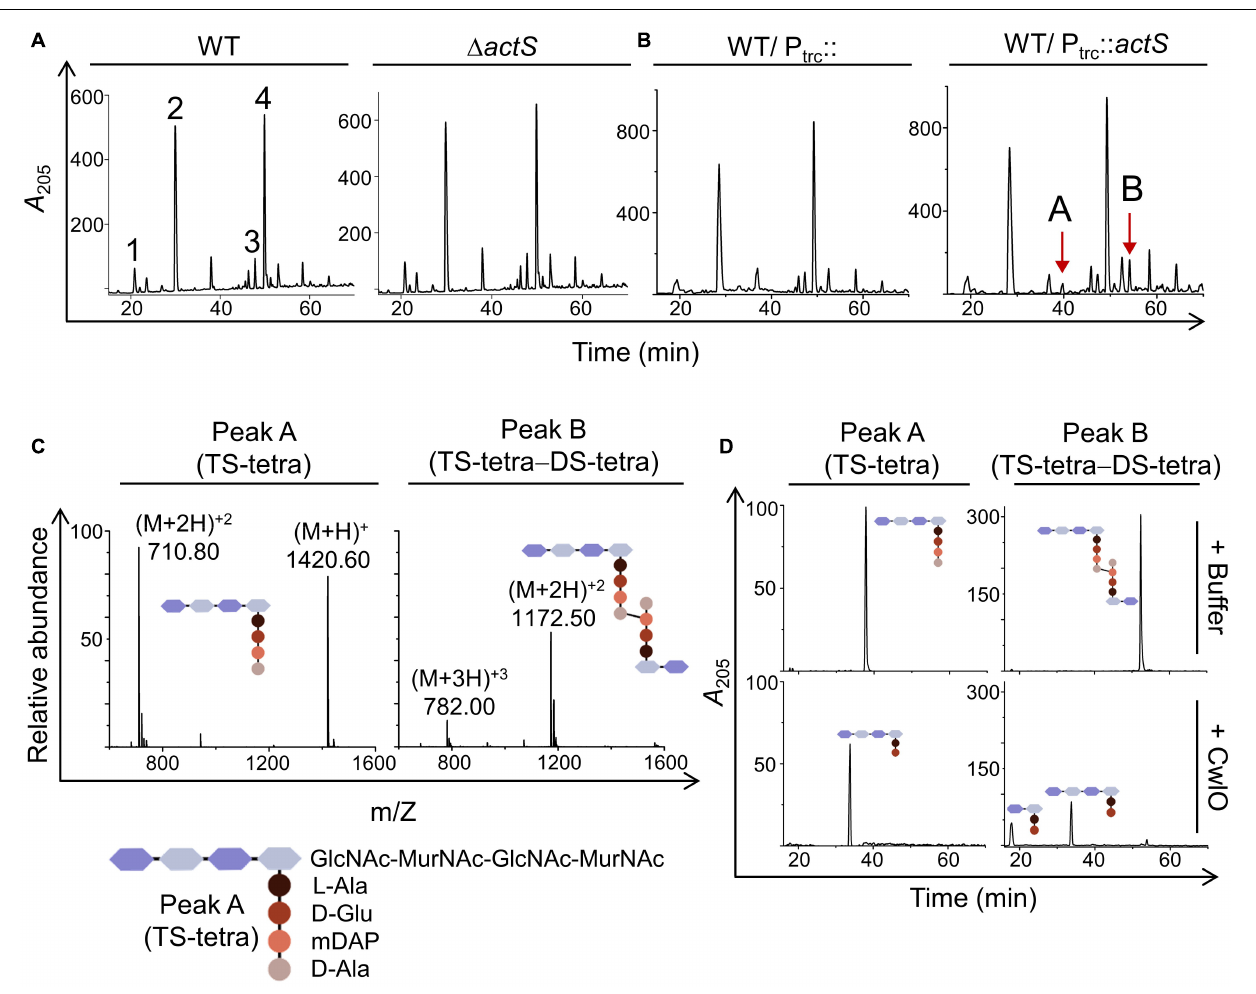
FIGURE 3 | Effect of actS on the composition of PG. (A) HPLC chromatograms depicting the PG composition of WT and (cid:49) actS mutant. Peak 1: disaccharide tripeptide (tri), peak 2: disaccharide tetrapeptide (tetra), peak 3: tri-tetra (3-3), peak 4 - tetra-tetra (4-3). (B) HPLC chromatograms depicting the PG composition of cells overexpressing ActS. The additional muropeptide peaks are represented as peaks A and B. (C) Mass spectra of peaks A and B with molecular mass of 1,420 Da [(M + 2H) + 2 of 710.80 Da] and 2,346 Da [(M + 2H) + 2 of 1,172.50 Da], respectively. Peak A is tetrasaccharide tetrapeptide (TS-tetra), whereas peak B is tetrasaccharide tetrapeptide cross-linked to disaccharide tetrapeptide (TS-tetra-DS-tetra). Structures are depicted in the inset. (D) Purified TS-tetra and TS-tetra-DS-tetra were incubated either with buffer or purified CwlO (5 µ M) for 20 h at 30 ◦ C and separated by